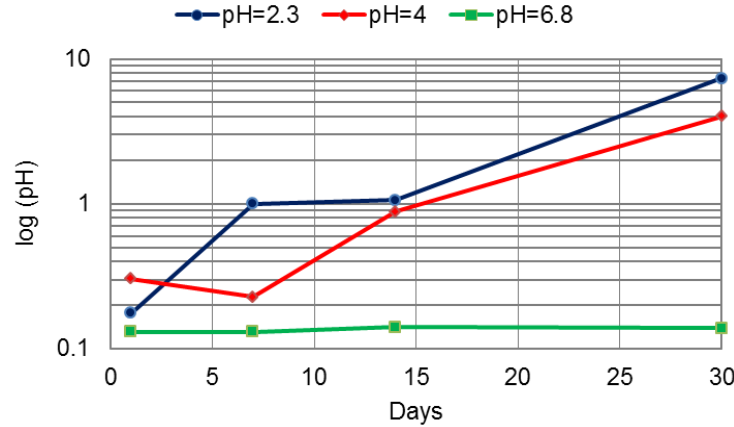
Figure 5. The difference between the release of Co from the CM and DMLS alloys (μg per cm 2 ) in artificial saliva of pH = 2.3, pH = 4 and pH = 6.8.